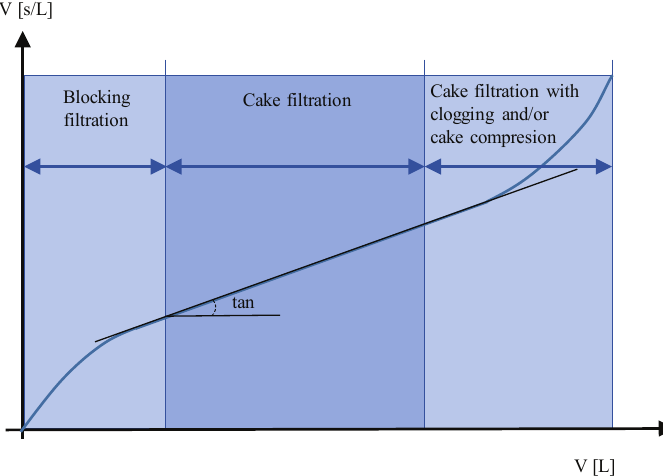
Figure 1. Ratio of filtration time and filtrate volume ( t / V ) as a function of filtrate volume ( V ) [38]. Copyright Elsevier,